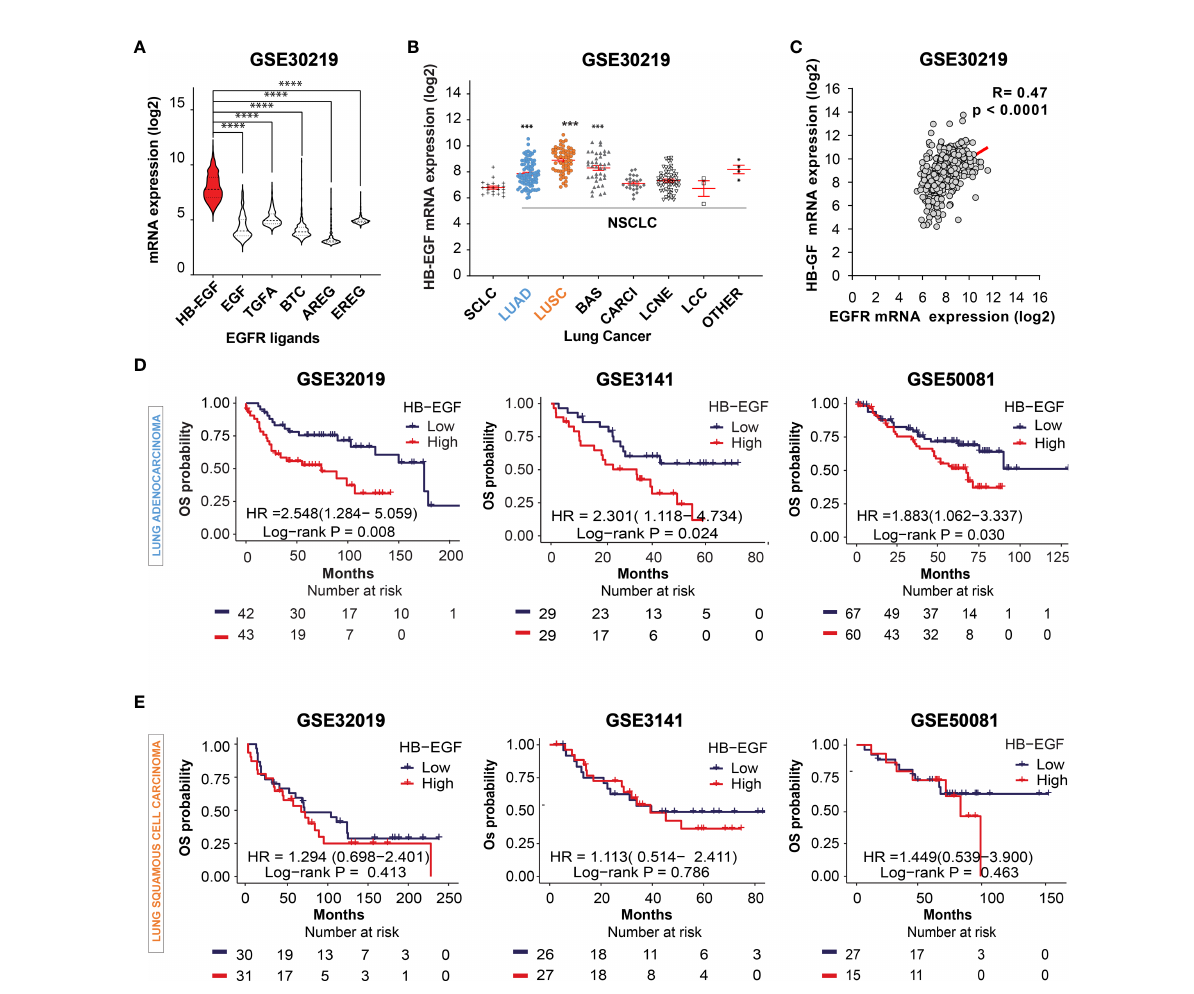
FIGURE 1 Prognostic potential of HB-EGF expression in LUAD (A) The gene expression levels of EGFR ligands, namely heparin-binding EGF-like growth factor (HB-EGF), epidermal growth factor (EGF), transforming growth factor- a (TGF- a ), betacellulin (BTC), amphiregulin (AREG), and epiregulin (EREG), in lung cancer were analyzed using the GSE30219 dataset. The levels of HB-EGF were compared with those of other ligands by using the Wilcoxon rank-sum test, ****P < 0.0001. (B) Expression of the HB-EGF mRNA level across different types of lung cancer, including lung small cell carcinoma (SCLC), lung adenocarcinoma (LUAD), lung squamous cell carcinoma (LUSC), lung cancer basaloid (BAS), lung cancer carcinoid (CARCI), lung cancer large cell neuroendocrine (LCNE), and large cell carcinoma (LCC) in GSE 30219 ***p < 0.001. (C) The correlation between the gene expression of HB-EGF and EGFR in GSE30219 was determined by performing Spearman ’ s rank correlation analysis. (D, E) Kaplan – Meier plot analysis of overall survival (OS) according to the HB-EGF mRNA expression level in patients with LUAD and LUSC in different GEO datasets (GSE30219, GSE3141, and GSE50081). We calculated p values by using the log-rank